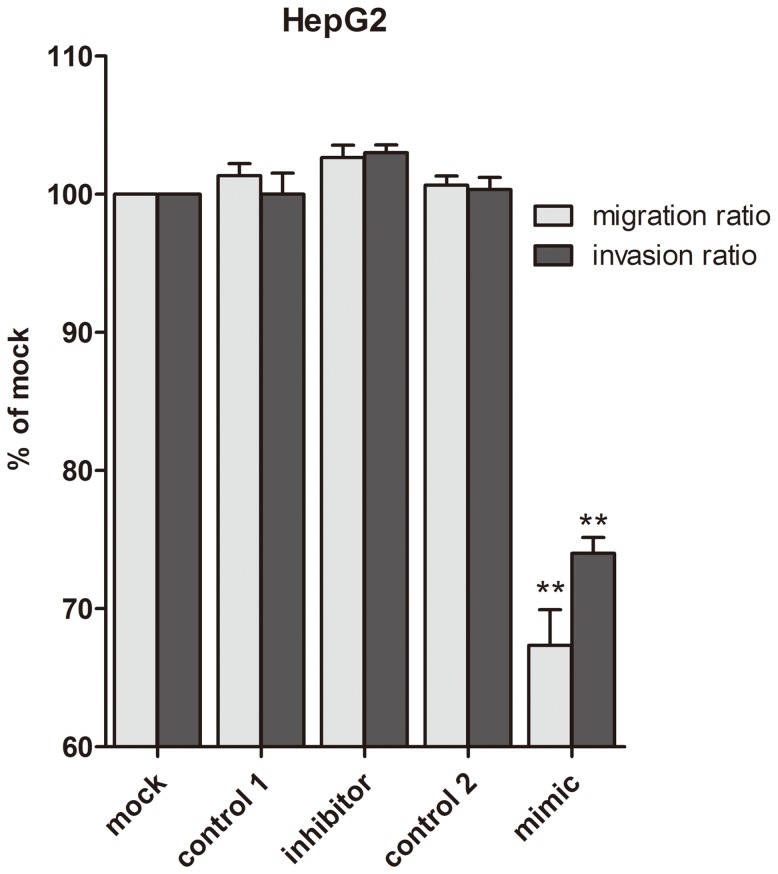
Effect of miR-34a inhibitor and miR-34a mimic on cell migration and invasion in HepG2 cells.HepG2 cells (5×104 cells per well using 6-well-plate) were cultured to 50% confluent and transfected with the miR-34a inhibitor, miR-34a mimic and the controls. The cells were incubated in serum-free medium for another one day 96 h post transfection. Then the cells were trypsinized and added (5×104 cells) to the chamber (6.5 mm in diameter, 8 µm pore size) for both migration and invasion assays. migrating and invasive cells were fixed, stained, counted and the ratio of cell migration and cell invasion was calculated.